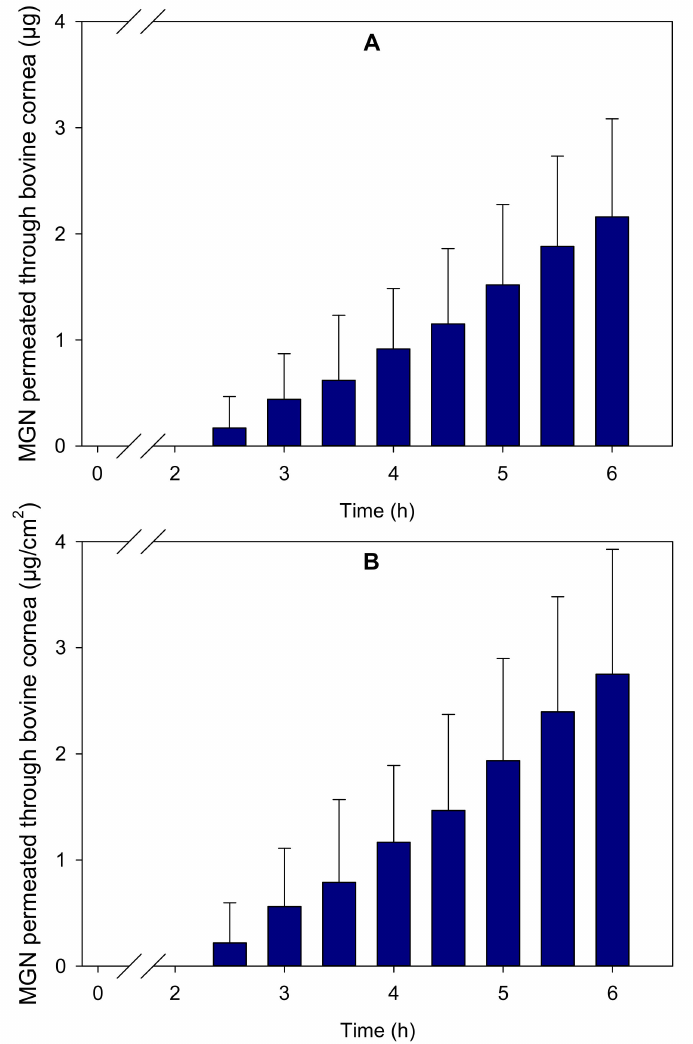
Figure 5. Accumulated amounts of MGN that permeated through bovine cornea for 6 h, expressed as ( A ) µ g and ( B ) µ g/cm 2